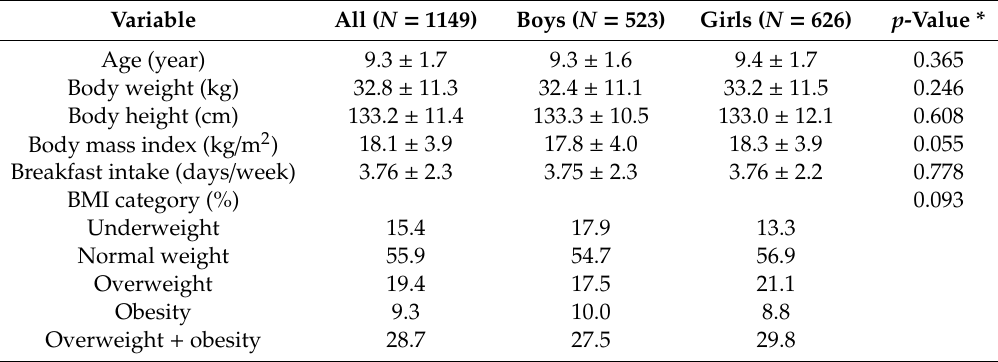
Table 1. Descriptive characteristics of the participants relative to